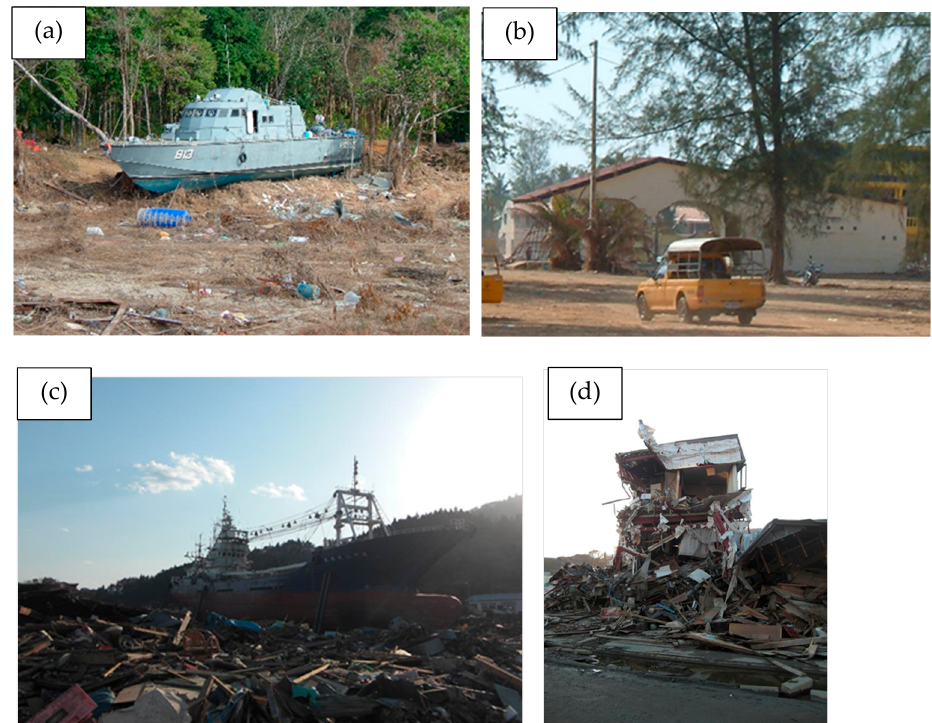
Figure 3. Damage from cars: ( a ) a dump truck collided against a warehouse at the Kirinda fishing port in Sri Lanka, ( b ) a passenger car collided against a shop at Miyako in Japan, and ( c ) many cars were pushed against the corner of a school building at Sendai in Japan.